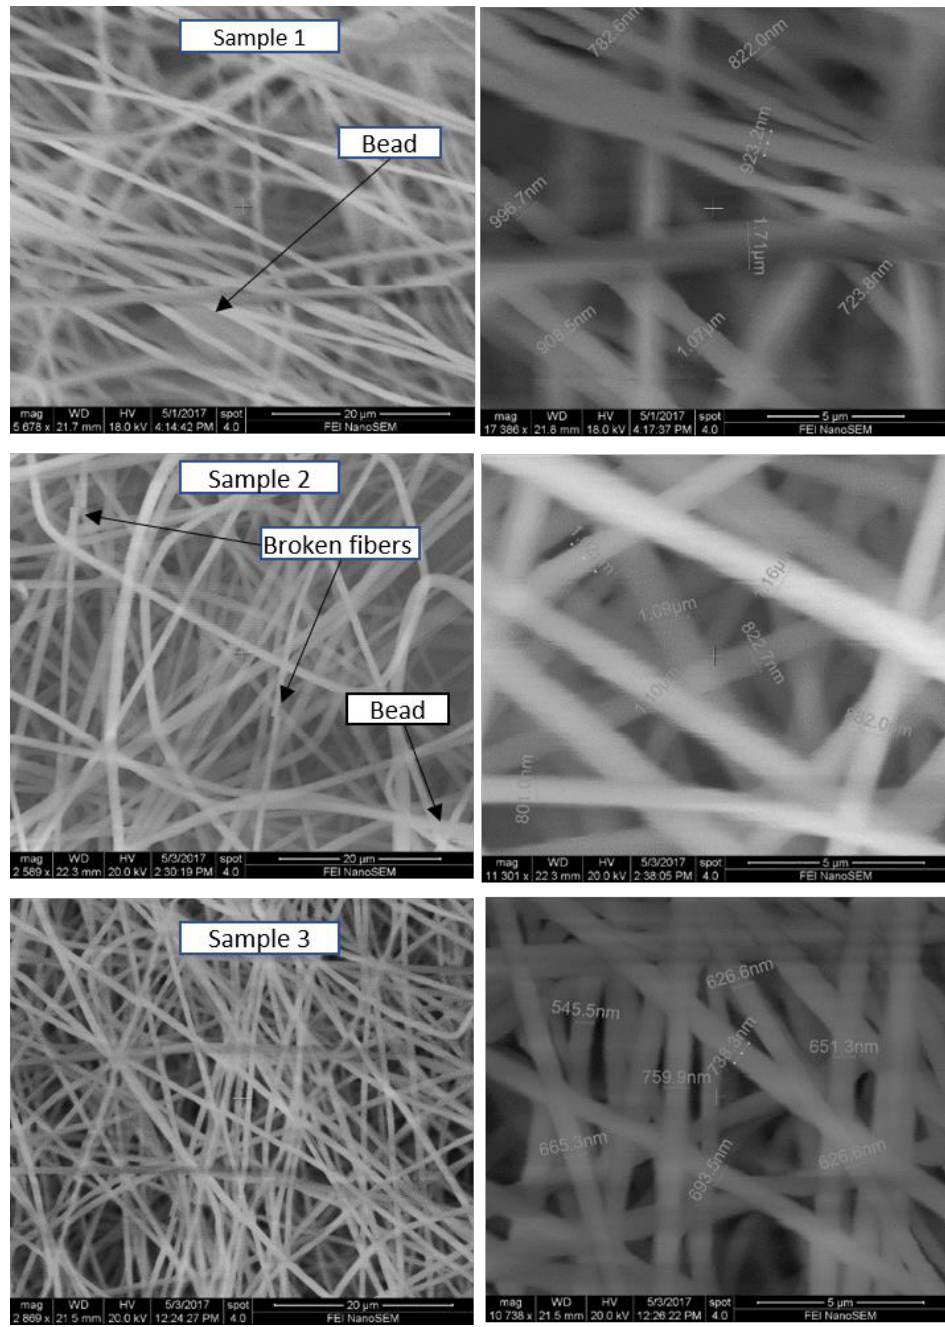
Figure 24. SEM images at 20 and 5 μm of Samples 1, 2, and 3 [ 171 ] .